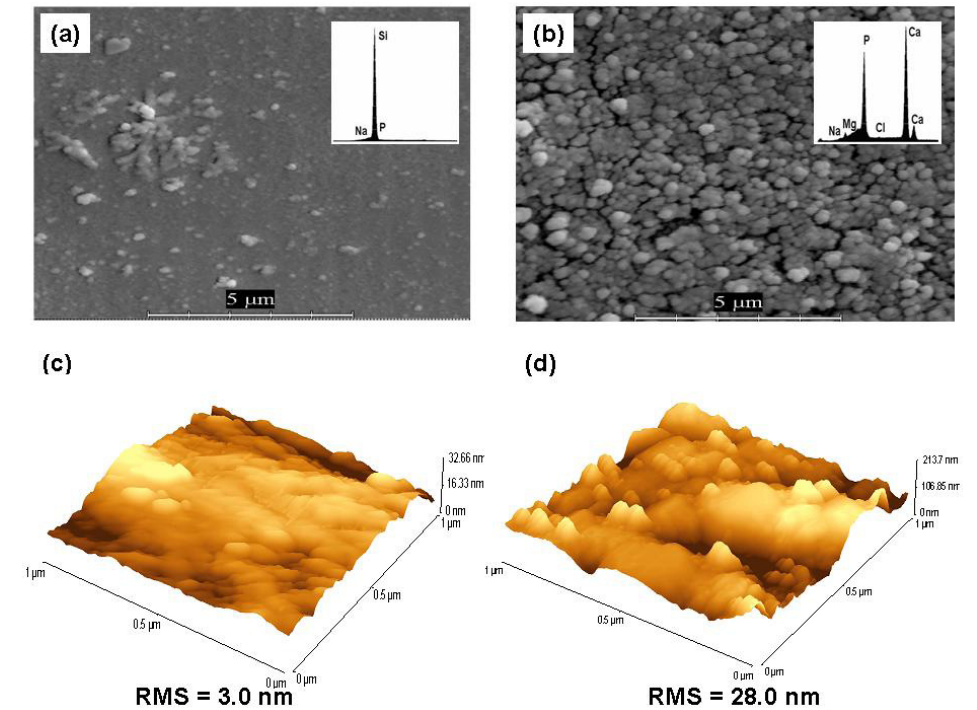
Figure 4. SEM - EPMA surface analysis (a, b) and AFM images (c, d) of glass ceramic samples (a, c – GC0, b, d – GC14) after 7-day immersion in